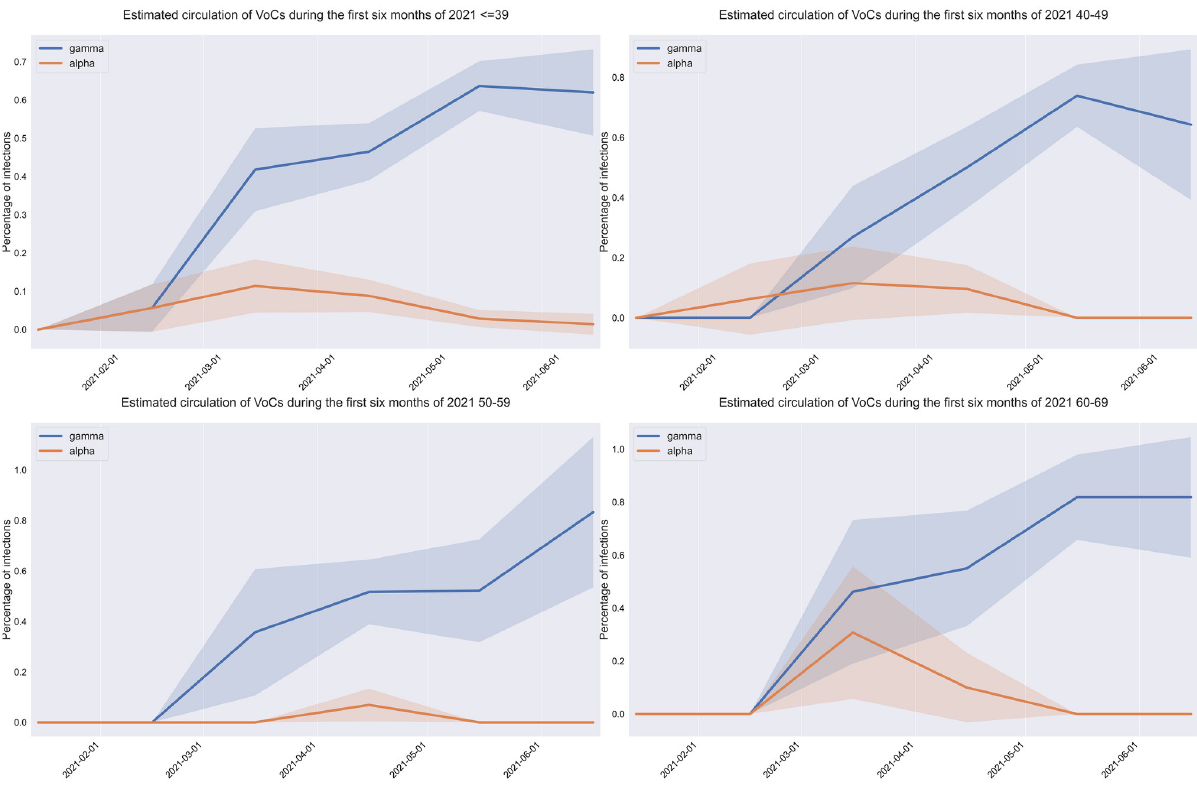
Fig 2. Estimated circulation of VOCs during the first five months of 2021. The blue and red curves depict the estimated percentage of infections associated with the Gamma and Beta variants, respectively, from January through May, 2021. The shaded area represents 95% confidence intervals for these